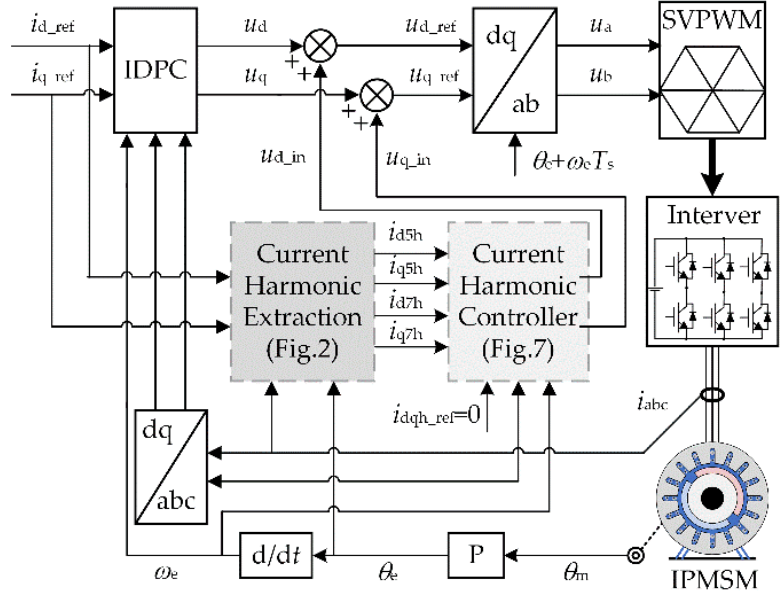
Figure 8. The block diagram of proposed current harmonic suppression strategy.